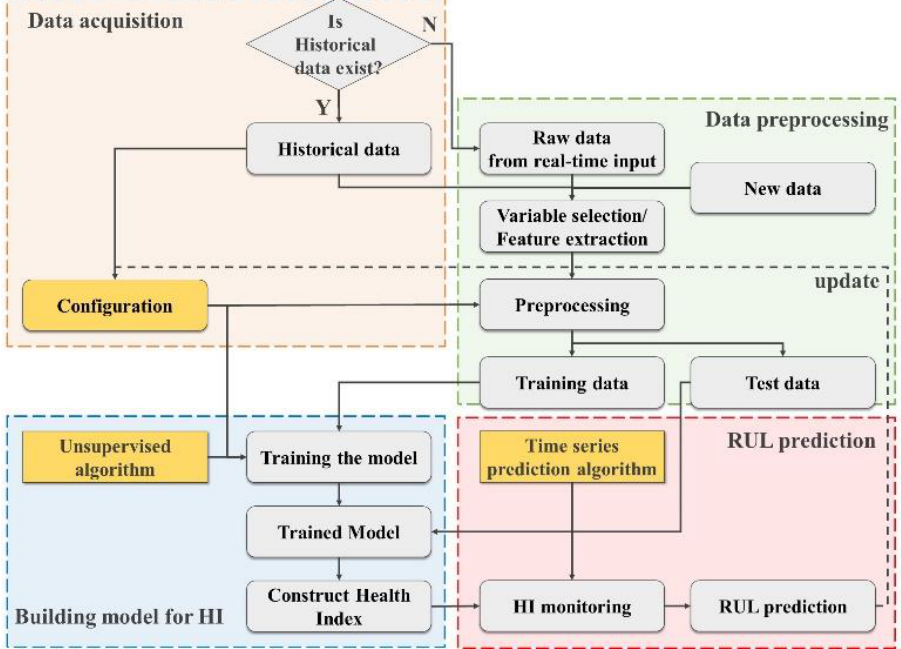
Figure 2. The proposed framework for an applicable Predictive Maintenance System in the absence of run-to-failure data.